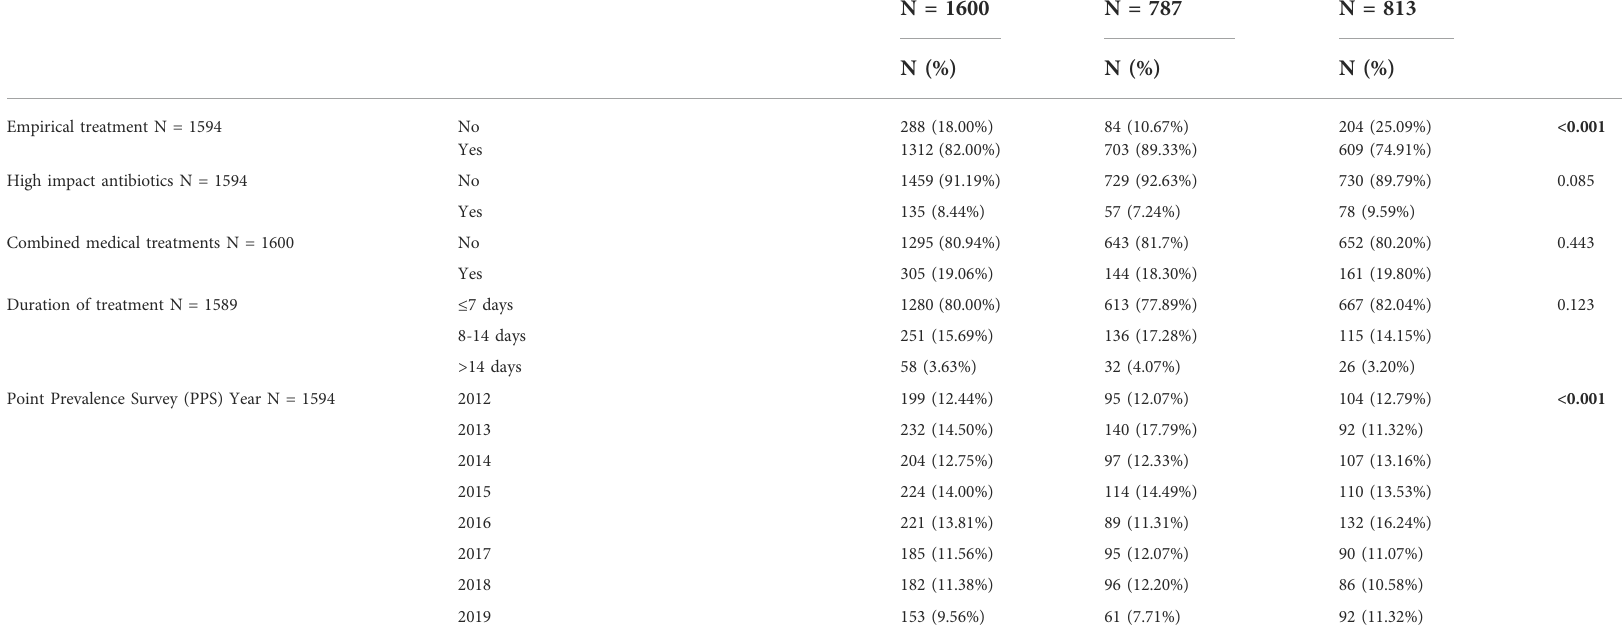
TABLE 1 ( Continued ) Overall demographics, clinical features and antibiotics usage (N = 1600 antimicrobial